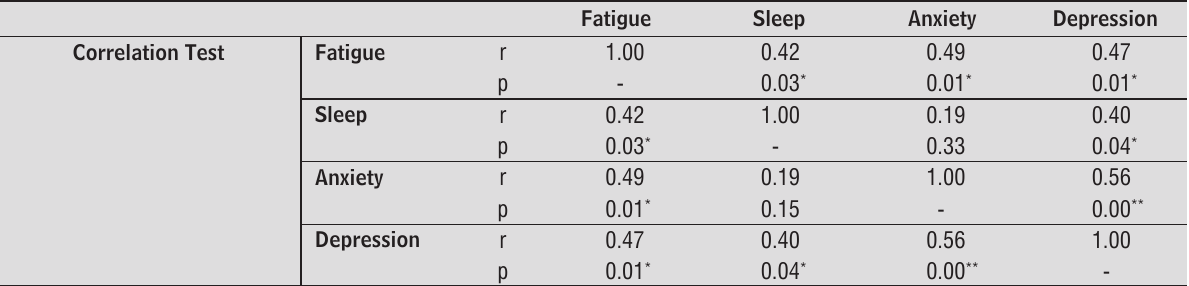
Depression p 0.01 * 0.04 * 0.00 **